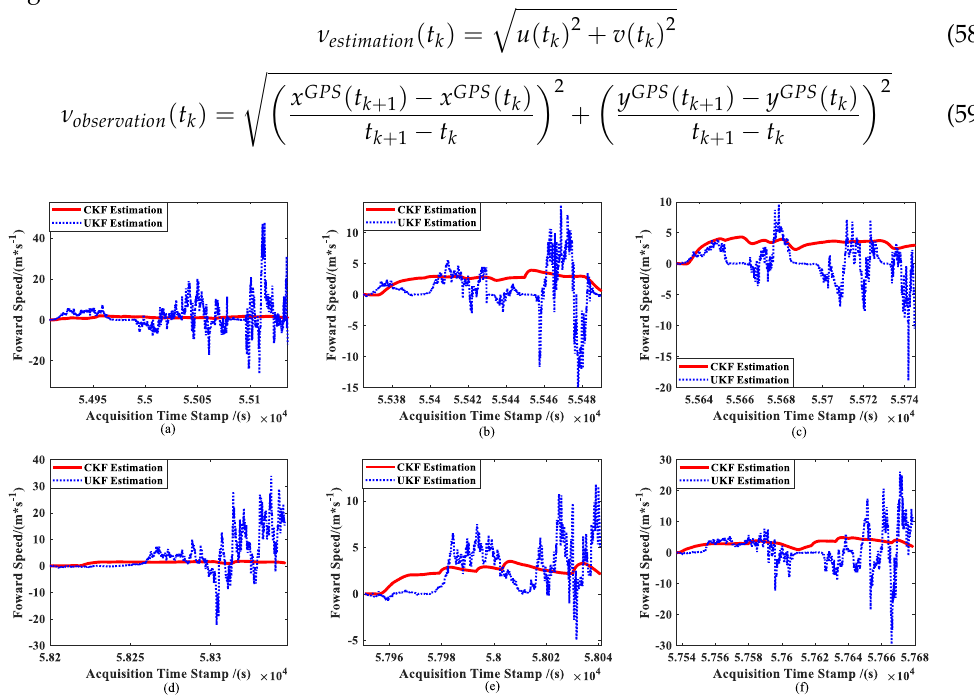
Figure 10. Comparison of ship forward speed estimations: ( a ) slow speed of MRM, ( b ) medium speed of MRM, ( c ) high speed of MRM, ( d ) slow speed of ANM, ( e ) medium speed of ANM, and ( f ) high speed of ANM.